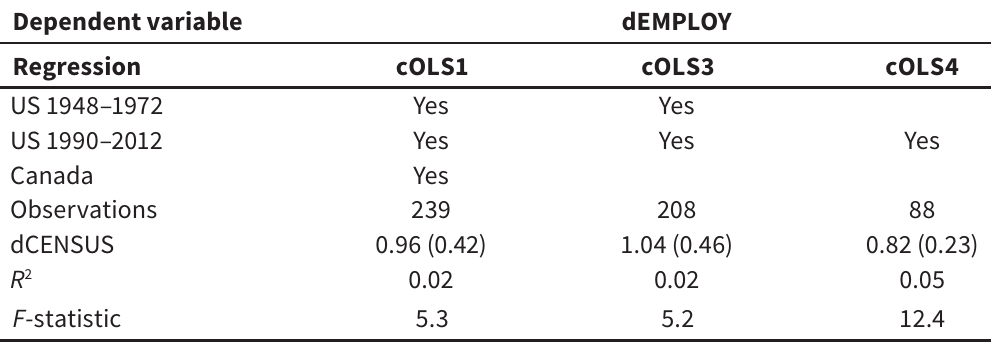
Total employment and census employment Dependent